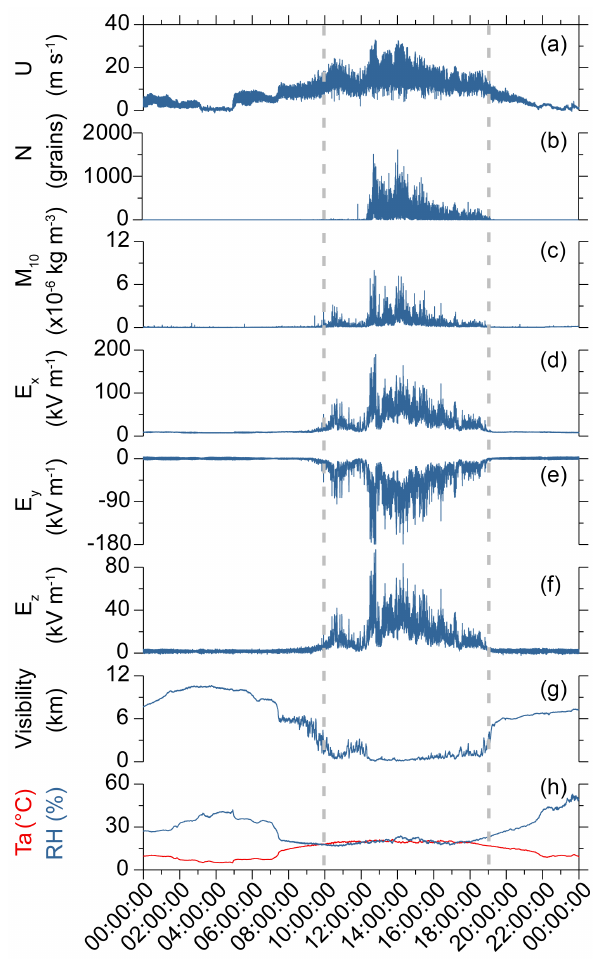
Figure 2. Data series recorded on 17 April 2017 (UTC + 8). Top- to-bottom: streamwise wind speed, saltating sand number passing through the measurement area (2mm in height and 25mm in length) per second, PM 10 mass concentration and 3-D E-fields at S9; visi- bility, ambient temperature and RH at S12. The E-fields E x , E y and E z are positive if they point in the positive directions of x , y and z axes depicted in Fig. 1. That is, E z and fair-weather atmospheric E -field are oppositely